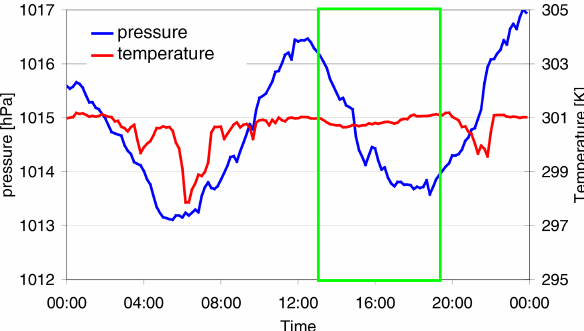
Figure A5. Diurnal variation of the surface pressure and temperature from in situ measurements on the ship. The green box indicates the period of the MAX-DOAS measurements used in this study. The corresponding values from the ECMWF model simulations are 1012.8hPa and 299.8K, respectively.